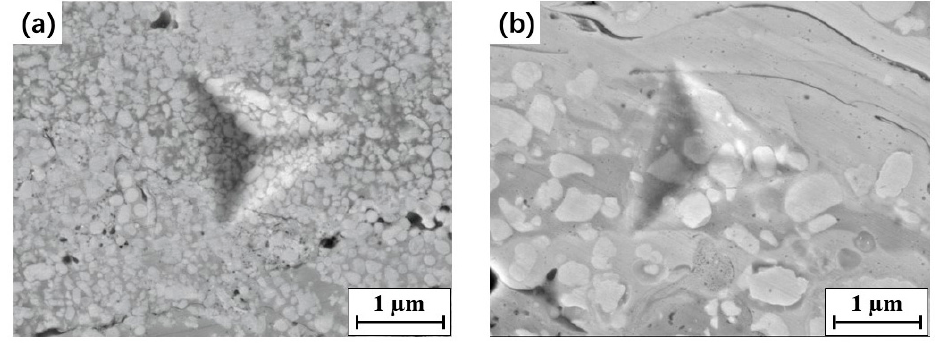
Figure 7. The typical SEM micrographs of nanoindentation imprint on the coatings: ( a ) N; ( b ) M.